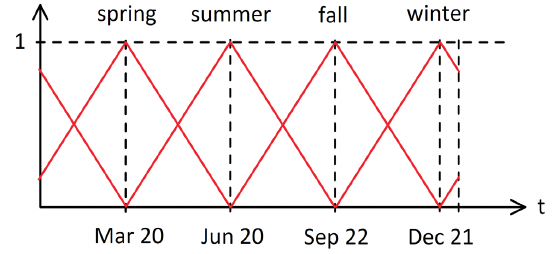
Figure 4. Triangular fuzzy set on the seasons of the